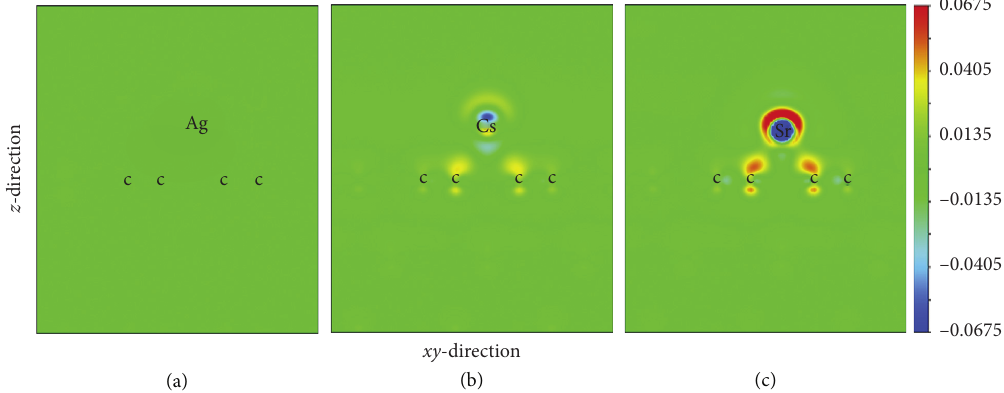
Figure 5: Charge density difference (CDD) based on the green bash lines shown in Figure 4(a) of fission products on perfect matrix graphite surface. (a) Ag; (b) Cs; and (c) Sr. Red and blue areas represent positive and negative charge differences. Isosurface level was set at 0 . 0069e/˚A 3 .